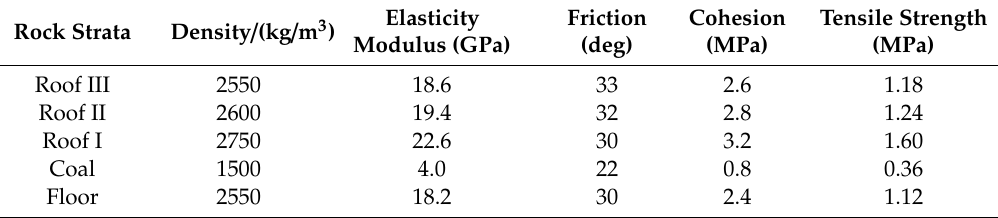
Figure 5. Numerical grid model. Table 1. Rock mechanical parameters in model.